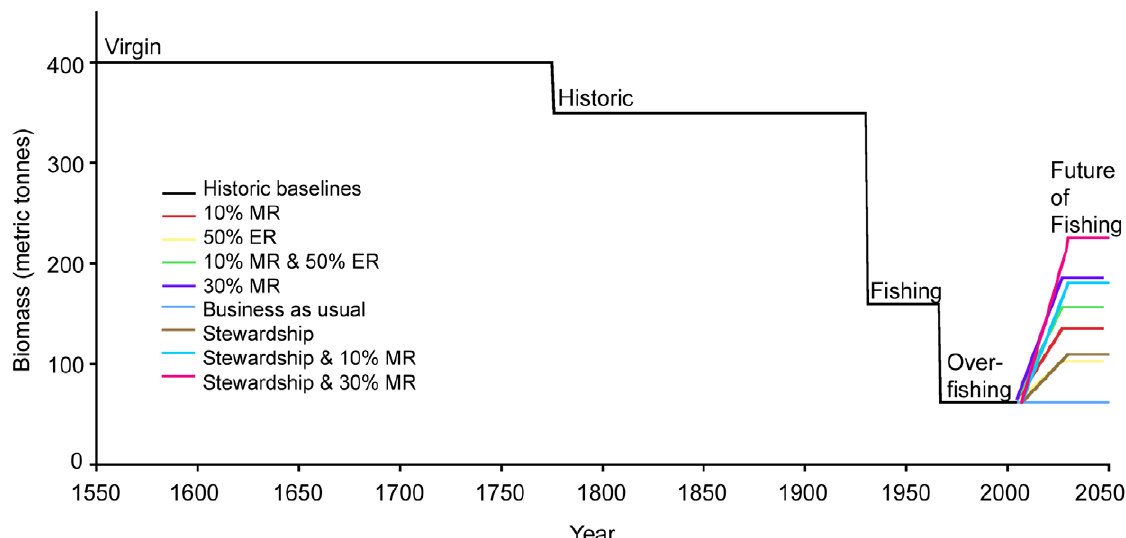
Figure 4. Shifting baselines in lobster abundance in the Juan Ferna´ndez Archipelago. Calculated baselines for 1550–2008 and predictions for ‘future of fishing’ modeling scenarios (2008–2050). doi:10.1371/journal.pone.0013670.g004 period, corresponding to the observed catch record (Figure 5). The model is highly sensitive to the catchability term ( q ) as competing models without the term could not be optimized to run for the duration of the period.